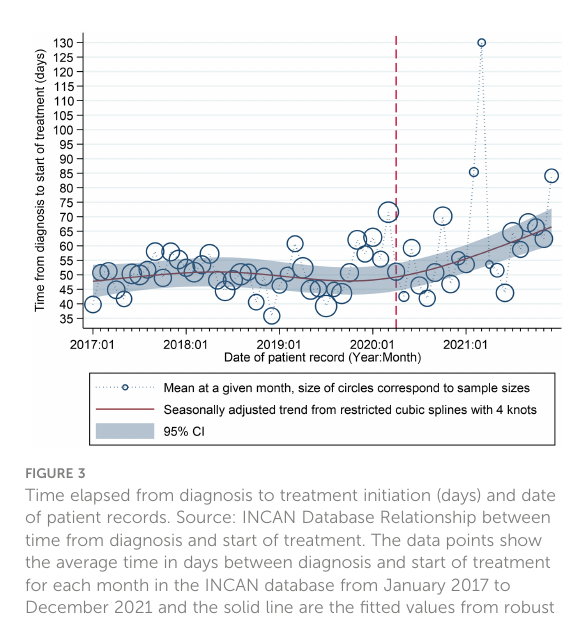
FIGURE 3 Time elapsed from diagnosis to treatment initiation (days) and date of patient records. Source: INCAN Database Relationship between time from diagnosis and start of treatment. The data points show the average time in days between diagnosis and start of treatment for each month in the INCAN database from January 2017 to December 2021 and the solid line are the fi tted values from robust regression model. The dashed line marks the start of our de fi ned pandemic